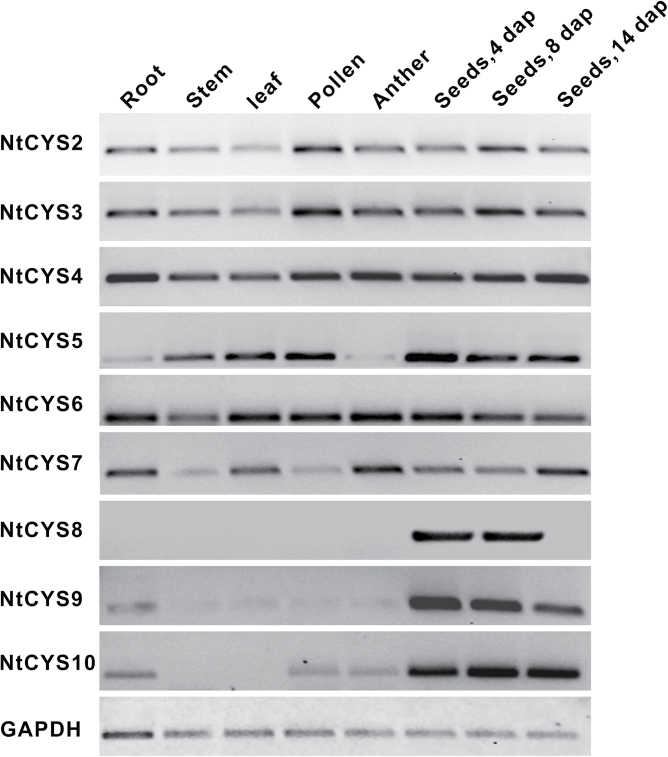
RT–PCR examination of the transcripts of novel cystatin family genes in tobacco. cDNA prepared from root, stem, leaf, pollen, anther, and seeds at stage 1, 5, and 9 were selected as templates for PCR. Glyceraldehyde-3-phosphate dehydrogenase (GAPDH) was used as the control. The nine stages of seed development were divided according to the corresponding stages of embryogenesis in tobacco (Zhao et al., 2013).